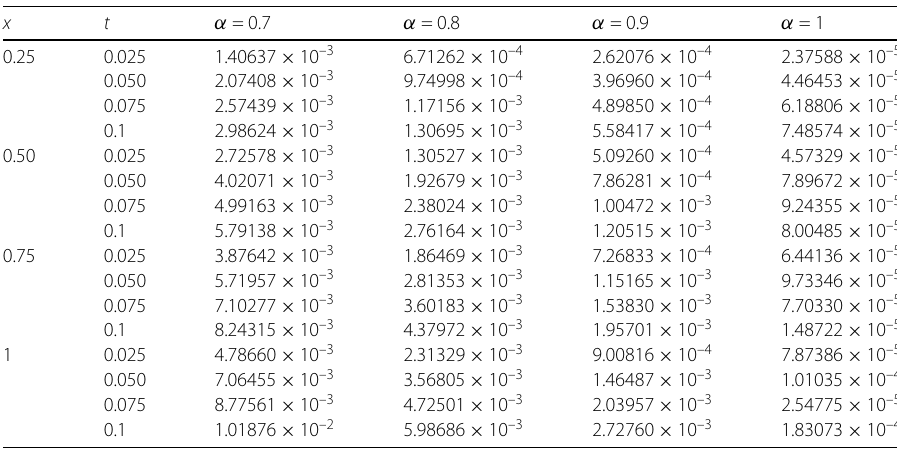
Table 1 Numerical illustration for the q -HATM solution of FEFK equation defined in Case 2 for distinct α at n = 1, (cid:2) = 1 and y =